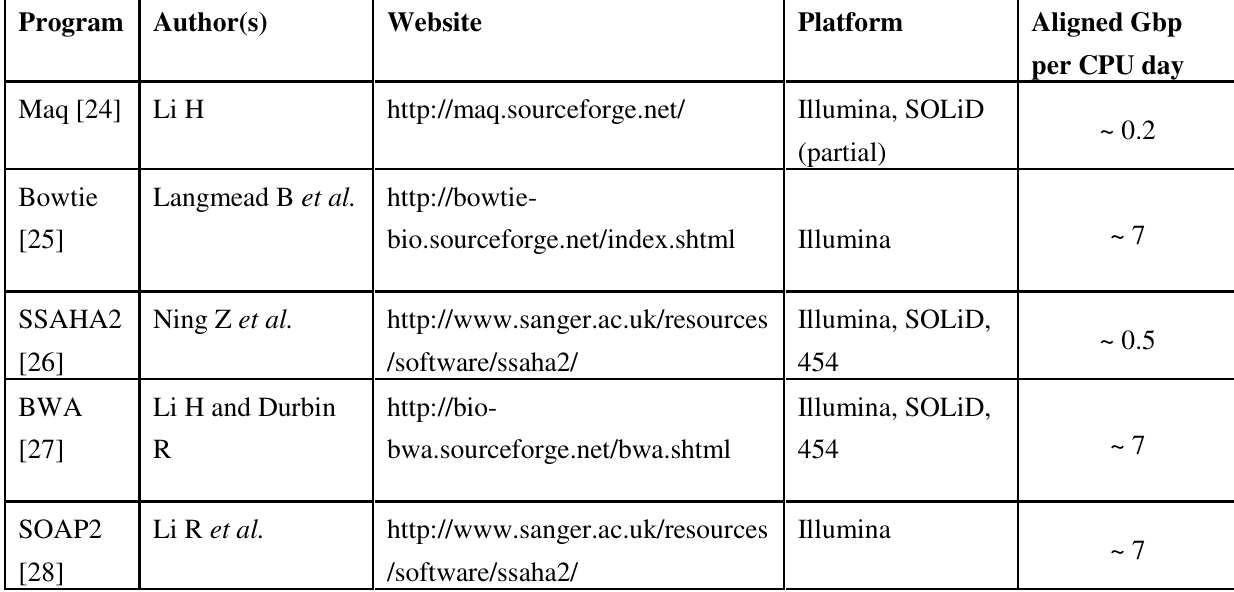
Table 2. A selection of short reads alignment tools. The platform compatibility depends on the maximum read length supported by the